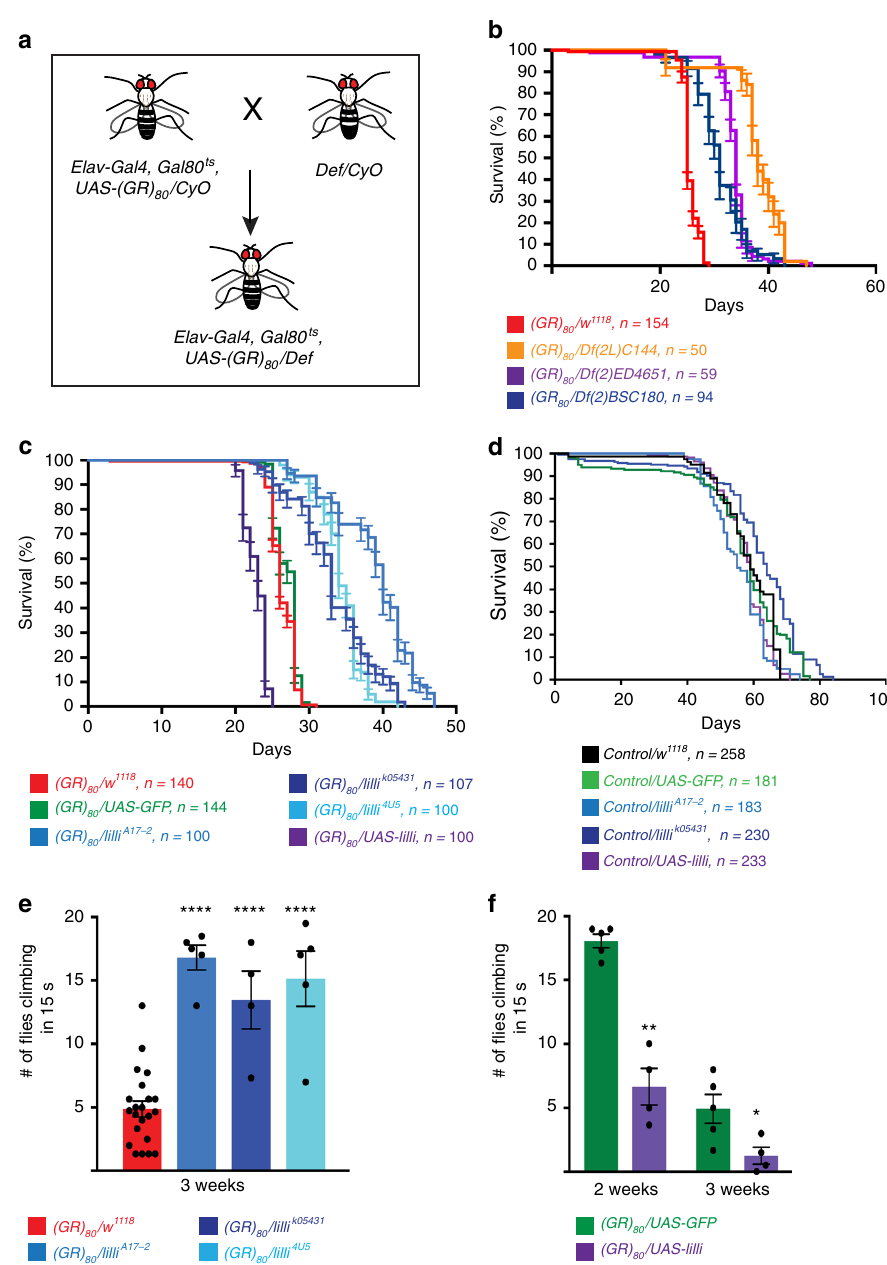
Fig. 3 Identi fi cation of lilli as a strong genetic suppressor of poly(GR) toxicity. a The design of a genetic de fi ciency screen in Drosophila . Def, de fi ciency lines. b De fi ciencies Df(2L)C144 , Df(2)ED4651 , and Df(2)BSC180 in trans signi fi cantly extended the lifespan of (GR) 80 fl ies. The n number for each genotype is in the fi gure. p < 0.0001 (log-rank test). c Survival analysis of (GR) 80 fl ies that are heterozygous for different lilli mutant alleles. Partial loss of Lilli activity by lilli A17-2 , lilli 4U5 , and lilli k05431 heterozygosity extended median survival by 14, 8, and 7 days, respectively. p < 0.0001 (log-rank test). Lilli overexpression decreased the median survival by 3 days. p < 0.0001 (log-rank test). The n number for each genotype is in the fi gure. d Effect of partial loss of Lilli activity on lifespan of control fl ies. The n number for each genotype is in the fi gure. e Reducing Lilli function rescues the climbing defect of (GR) 80 fl ies in the negative geotaxis assay. One dot = 20 fl ies, n = 22, 5, 4, and 5 assays for genotypes from the left to the right, respectively. **** p < 0.0001 (one-way ANOVA, Dunnett ’ s test). f Overexpression of Lilli enhanced the climbing defect of (GR) 80 fl ies. One dot = 20 fl ies, n = 5, 4, 5, 4 assays for genotypes from the left to the right, respectively. * p < 0.05; ** p < 0.01 (Welch ’ s test). Source data are provided as a Source Data fi from two C9ORF72 patients. About 80% of neurons generated repeats in the fi rst intron, decreased by 15% after AFF2 with this protocol are MAP2-positive 43 (Fig. 6b). Four-week-old neurons were transduced with lentiviruses expressing the shRNAs targeting each AFF family member and cultured for 10 days. (Fig. 6d). Gene expression changes after AFF1 or AFF4 knock- AFF2 and AFF3 shRNAs reduced target gene expression by 60 – 70% (Fig. 6c, d). Under these conditions, levels of C9ORF72 also affected (Supplementary Fig. 12). This observation is variant 3 (V3) mRNA, which encodes full-length C9ORF72